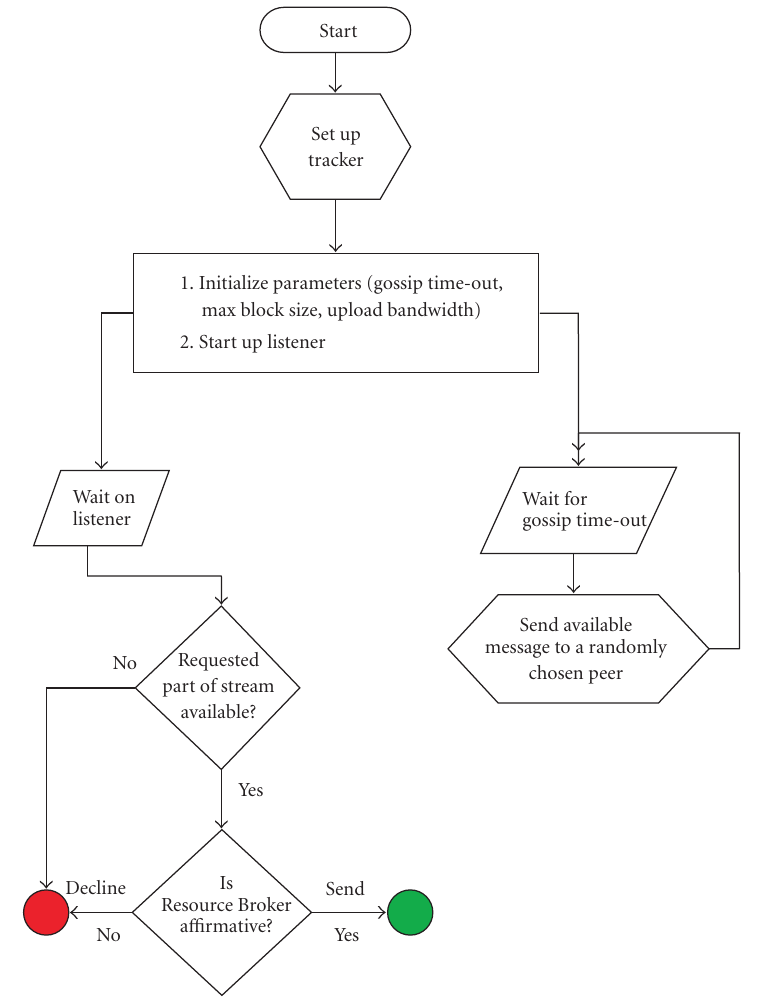
Figure 10: Streaming operation of the